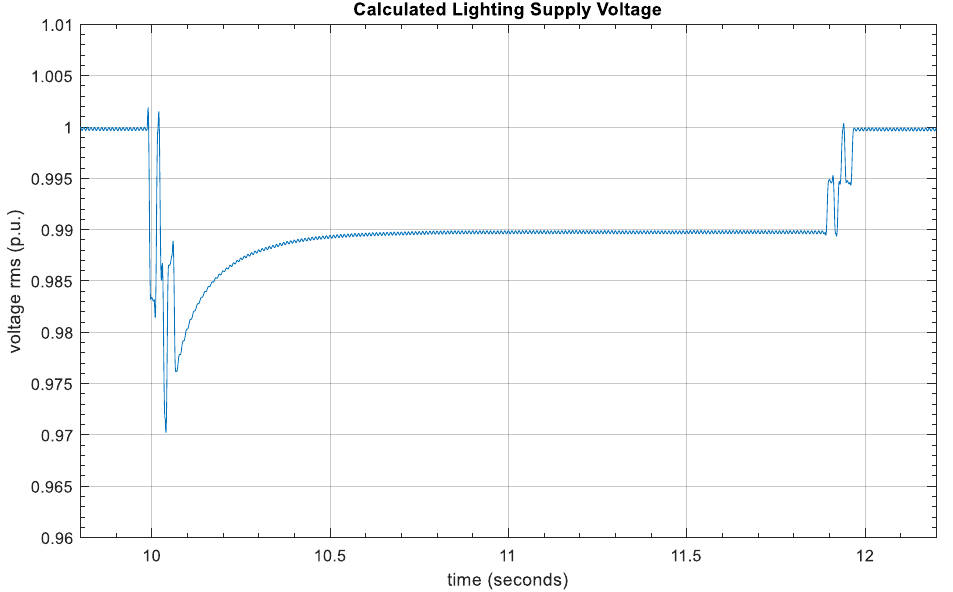
Figure 10. Typical lighting supply voltage disturbance calculated with the Matlab Simulink model.